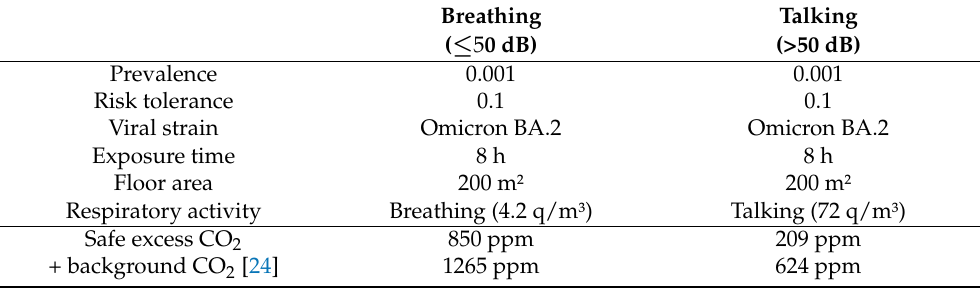
Table 1. Example of safe carbon dioxide (CO 2 ) concentrations for the occupant activities—breathing (working quietly) and